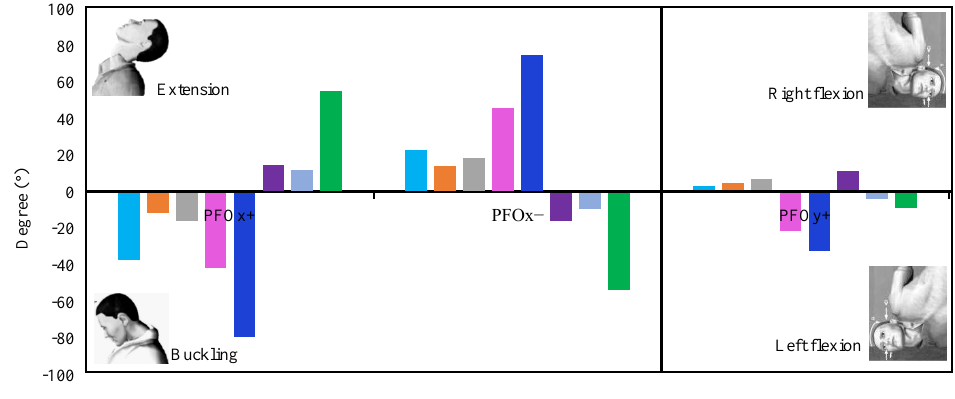
Figure 7. Maximum rotation angle of T1 relative to the head.